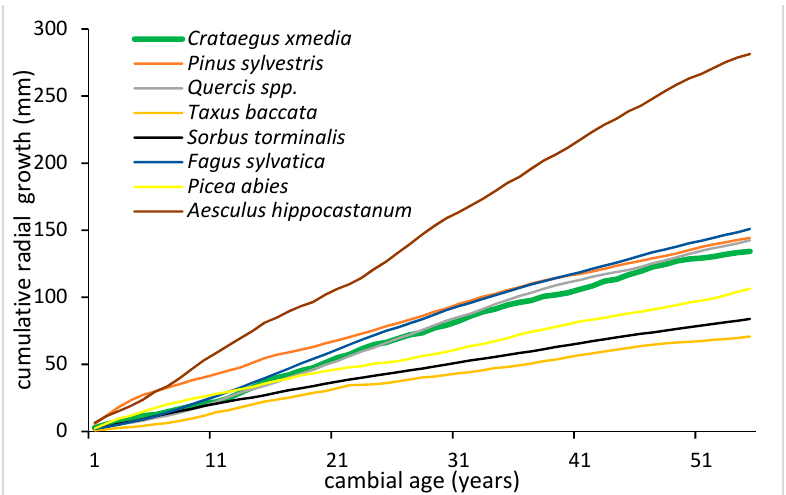
Figure 3. Cumulative radial growth of Crataegus media and Pinus sylvestris , Quercus spp., Picea abies , Fagus sylvatica , Taxus baccata , Sorbus torminalis , Aesculus hippocastanum expressed in mm. Growth profiles for all species represent the mean values of the species population from the northwestern part of Poland.